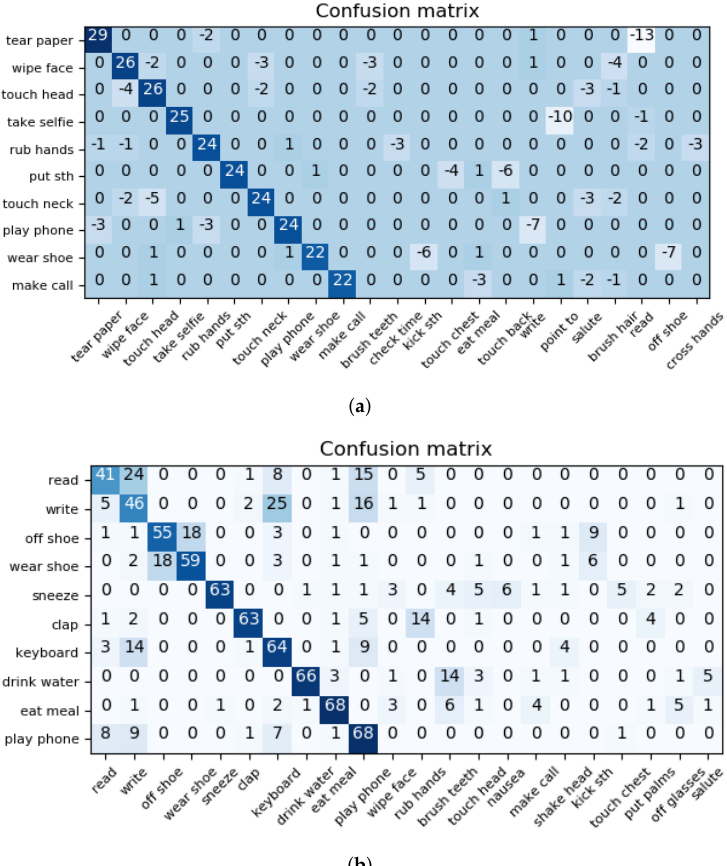
Figure 4. Illustration of the normalized confusion matrices (%) for the proposed model and its difference with the shallow LSTM-based attention model on the NTU dataset. Note that there are 60 classes in total, which is too large to show the entire difference matrix. Therefore, only part of the difference confusion matrix is shown. For the difference of the confusion matrix (confuse matrix of the proposed model minus that of the shallow LSTM-based attention model), the 10 rows represent the classes with the 10 largest differences between the proposed model and the shallow LSTM based attention model. The columns represent the classes that are confused with one of the classes in the rows and the difference between the proposed model and the shallow LSTM-based attention model is at least 2%. For the confusion matrix of the proposed model, the top 10 most confused classes are shown in the 10 rows. The columns represent the classes that are confused with one of the classes in the rows by at least 2%. Note that for the purpose of display, the action names are simplified without losing their meaning. Readers are referred to [29] for the full action names. ( a ) Difference of the confusion matrix between the proposed model and the shallow LSTM based attention model. ( b ) Confusion matrix of the proposed